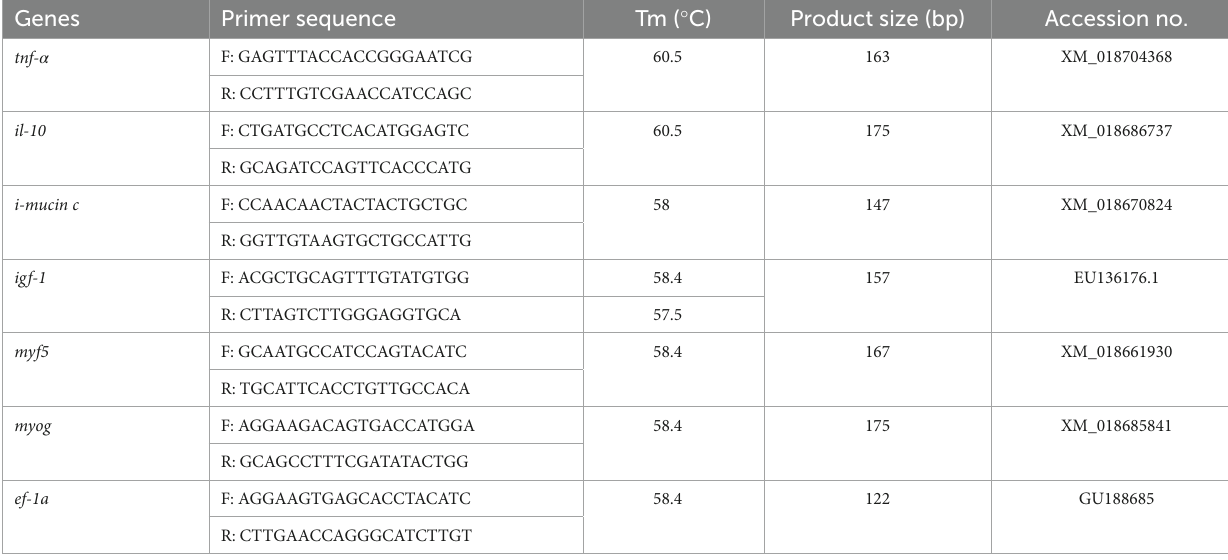
TABLE 3 Primers of tumor necrosis factor- α ( tnf- α ), interleukin-10 ( il-10 ), i-mucin C, insulin like growth factor-1 ( igf-1 ), myf5 , myog and elongation factor-1a ( ef-1a ) genes used in qPCR.